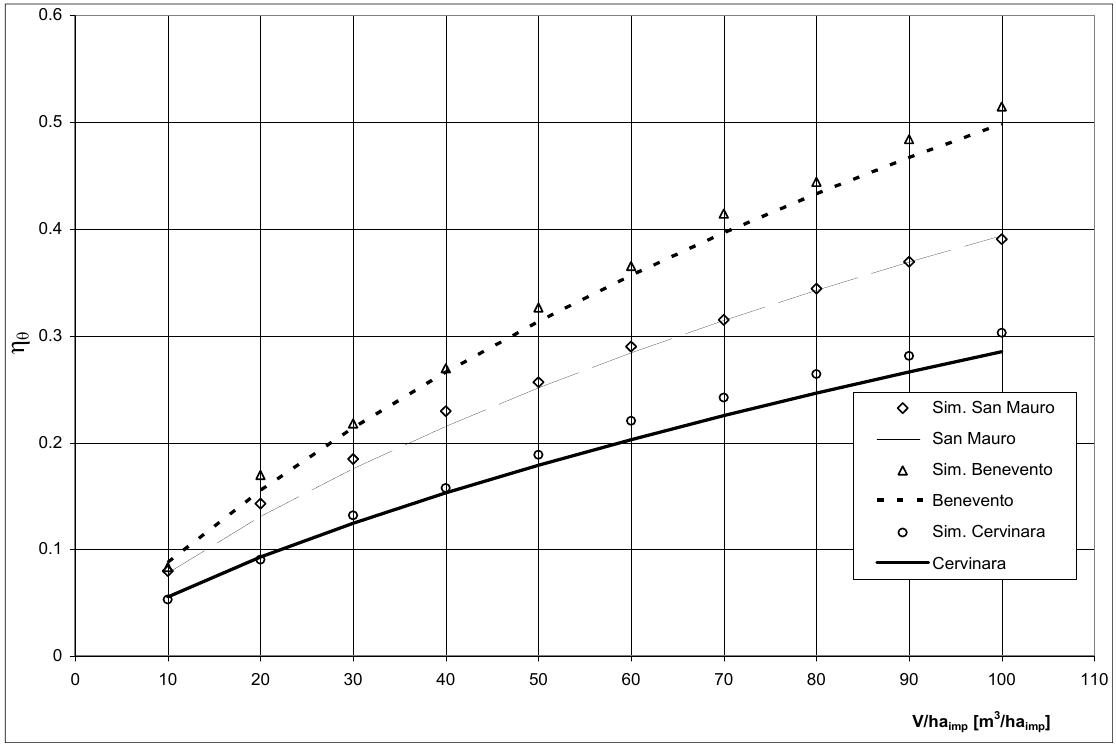
Figure 7. Average annual rainfall events entirely contained by the capture tank (C), varying with the specific volume, obtained using the continuous simulation (points) and semi-probabilistic (curves) values developed for IETD = 48 h and Ia = 1